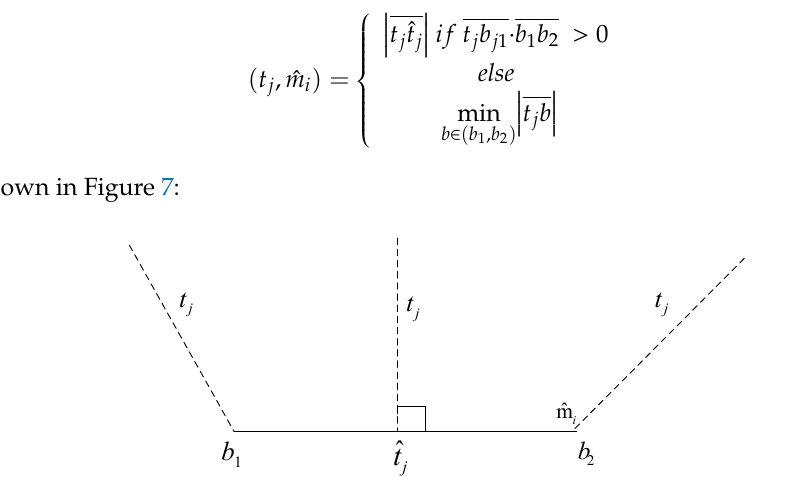
Figure 7. Distance from point t j to line m j under di ff erent conditions.